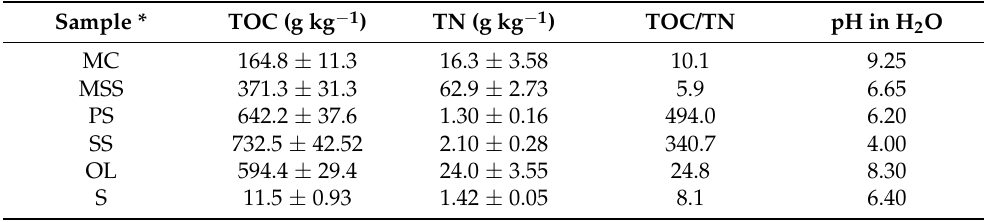
Table 1. Content of total organic carbon (TOC), total nitrogen (TN) and TOC/TN ratio in biochars and soil. Sample * TOC (g kg − 1